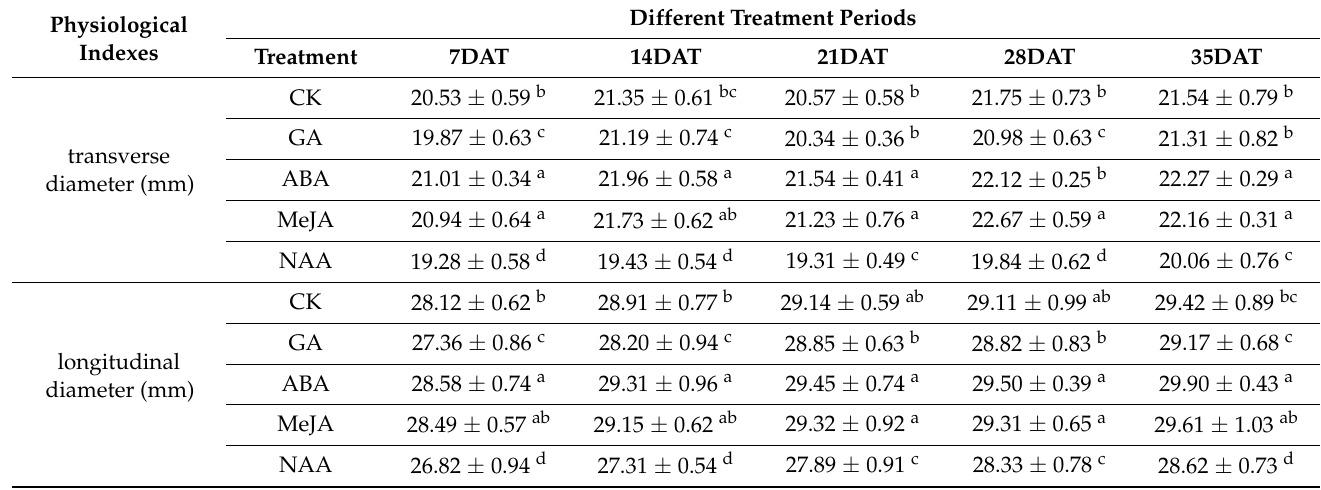
Figure 1. Physiological characteristics of ‘Wink’ grape treated with different hormones. ( A ) Morphological and color change. ( B ) The contents of soluble sugars (glucose, fructose, and sucrose). ( C ) Color Index of Red Grape (CIRG). ( D ) The contents of anthocyanins (cyanidin-3-O-glucoside chloride). Berry samples were randomly collected at 0 days after treatment (0DAT, 16 July), seven days after treatment (7DAT, 23 July), 14 days after treatment (14DAT, 30 July), 21 days after treatment (21DAT, 6 August), 28 days after treatment (28DAT, 13 August), and 35 days after treatment (35DAT, 20 August). Different letters on the bar graph indicate significant differences, and the same indicates no significant differences ( p < 0.05). Table 1. Physiological indexes of grape berry treated with different hormones.